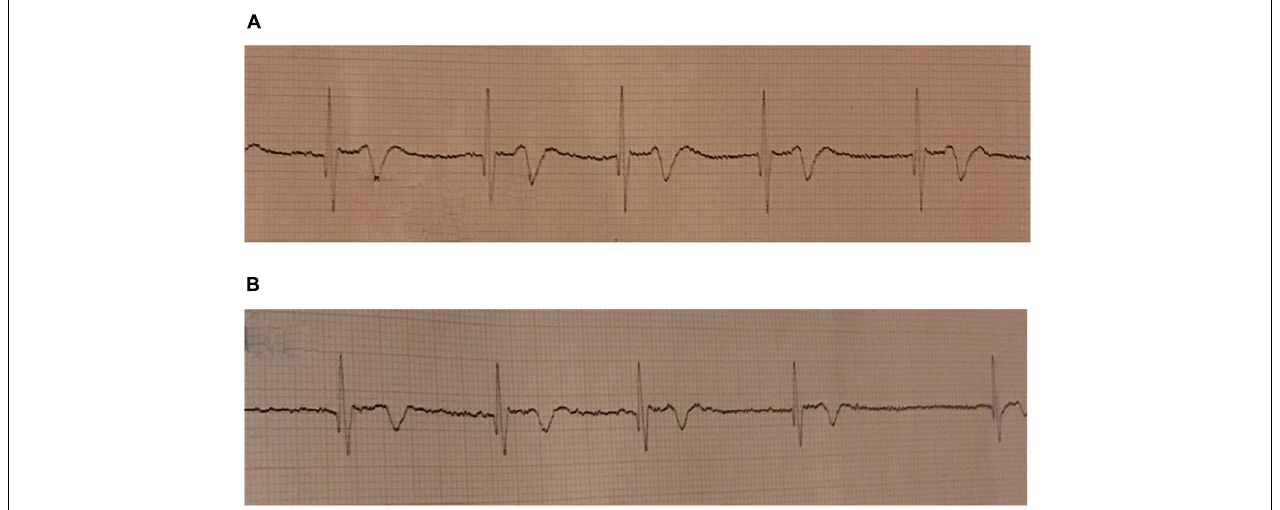
FIGURE 3 | ECG during maximum pool apnea in two subjects. (A) Nodal rhythm during maximum dry apnea. Recorded at 25 mm/s. (B) Atrioventricular dissociation during maximum pool apnea. Recorded at 25 mm/s.